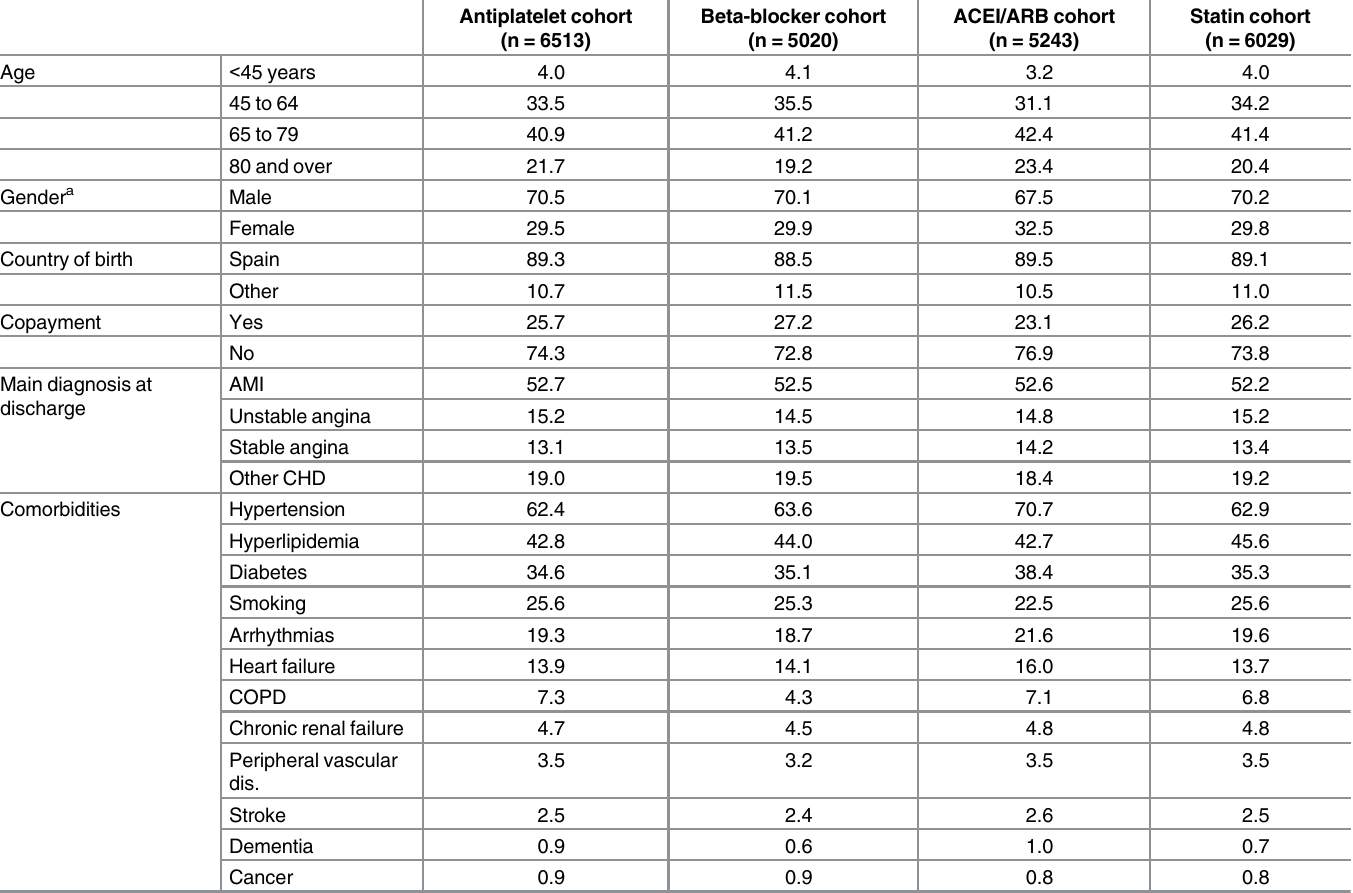
Table 1. Patient characteristics of the four medication cohorts a